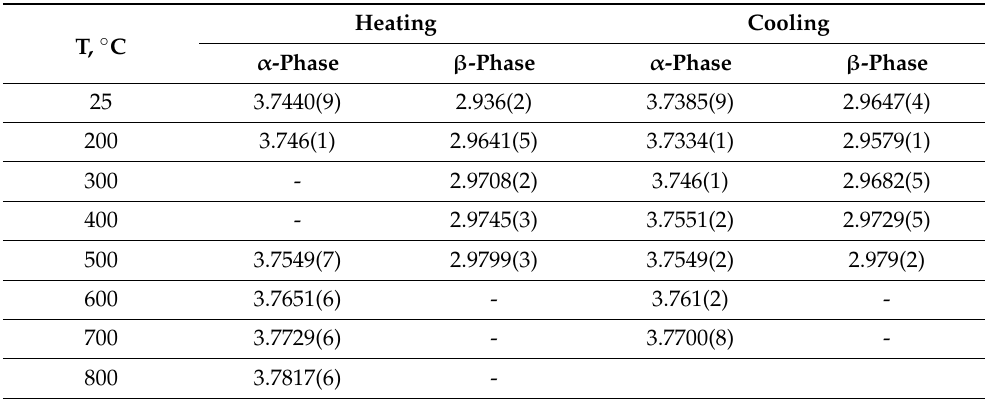
Table 1. Variation of the phase composition and crystal lattice parameters (a,Å) of the phases during the heating–cooling cycle of the Cu-Pd36